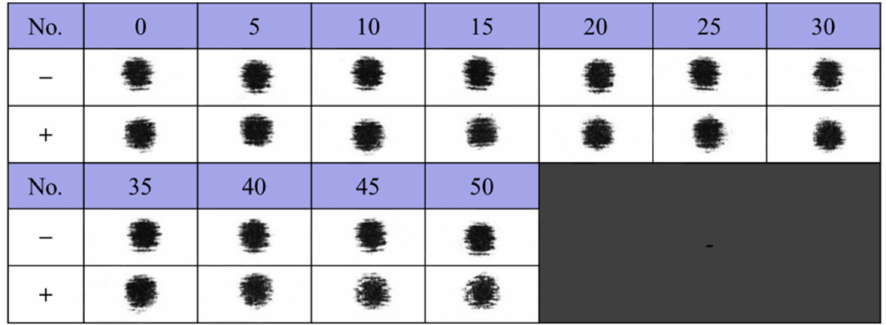
Figure 14. Carbon imprints of the abraded electrode at the electrode force of 600 kgf during continuous